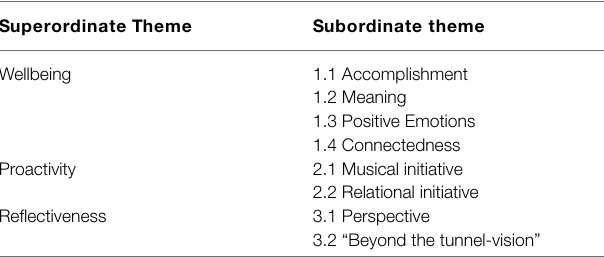
TABLE 1 | Superordinate and subordinate themes encapsulating the areas of change elicited by The Lullaby Project. Superordinate